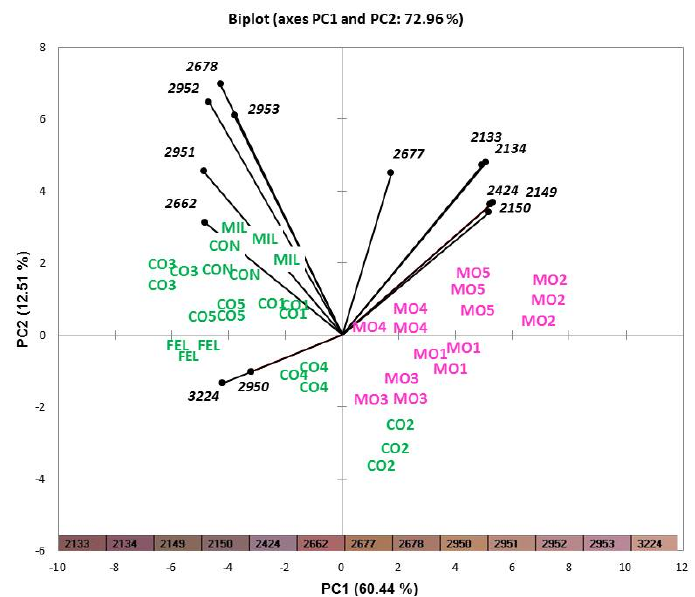
Figure 2. Projection of samples and variables (intensities and shades of red) on a plane (PCA). Conventional breeds and Mora Romagnola are labeled in green and pink, respectively. Samples were coded as CO1 (conventional salami with small size), MO1 (Mora Romagnola salami with the same size as CO1), CO2 (conventional salami of “Nostrano” type), MO2 (Mora Romagnola salami similar to CO2), CO3 (conventional salami of “Cacciatore” type), MO3 (Mora Romagnola salami similar to CO3), CO4 (conventional salami obtained directly from a local producer), MO4 (Mora Romagnola salami similar to CO4), CO5 (conventional salami obtained directly from a local producer),